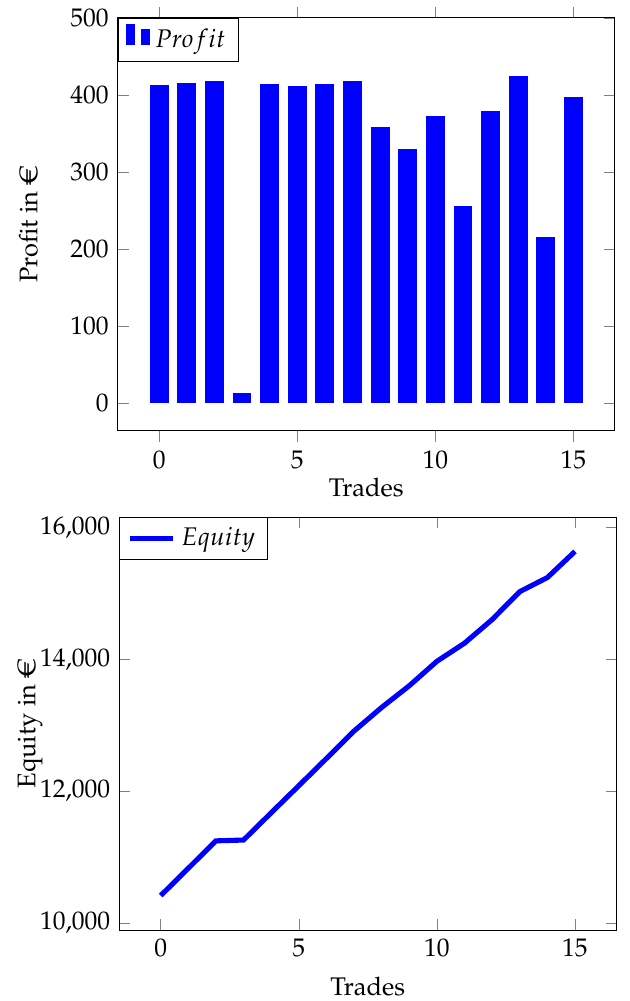
Figure 6. Top: The profits achieved in our real world example. Bottom: The equity development of our Figure 6. ( Top ) The profits achieved in our real-world example. ( Bottom ) The equity development of demo account. our demo